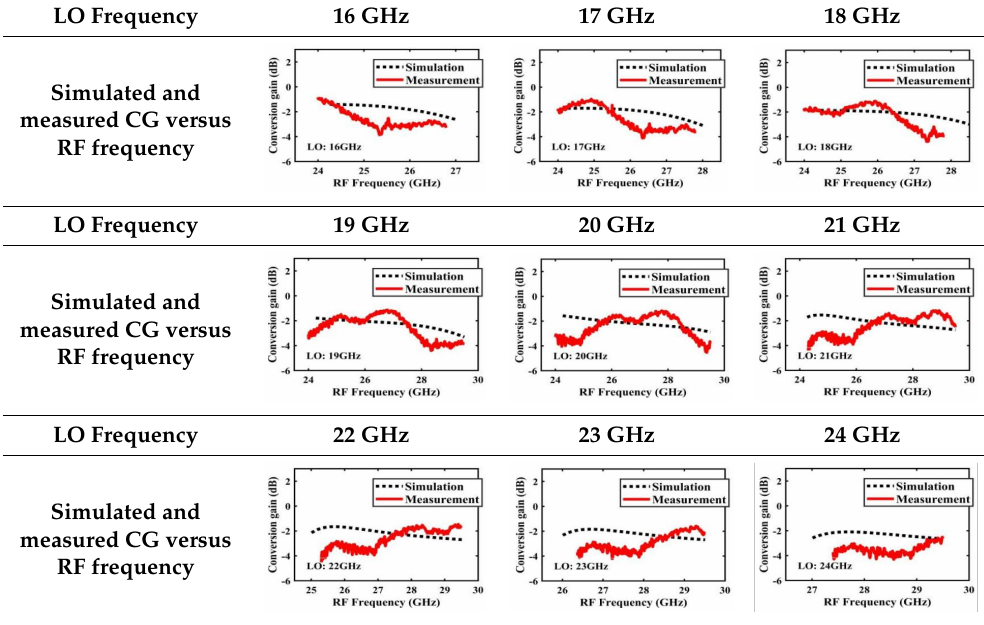
Table 2. Simulated and measured CG versus RF frequency under different LO frequencies.